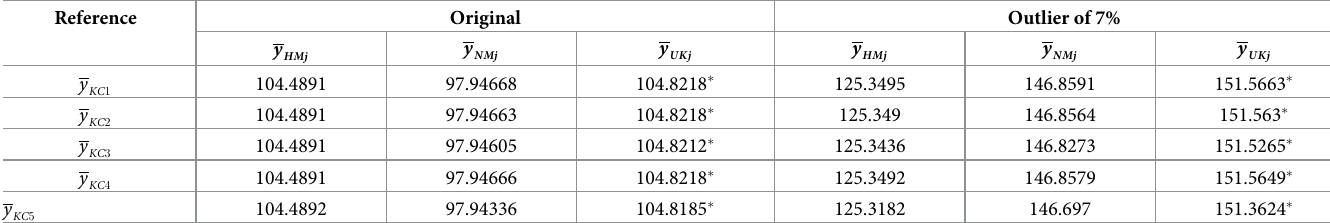
Table 4. PREs for the public school expenditures real dataset